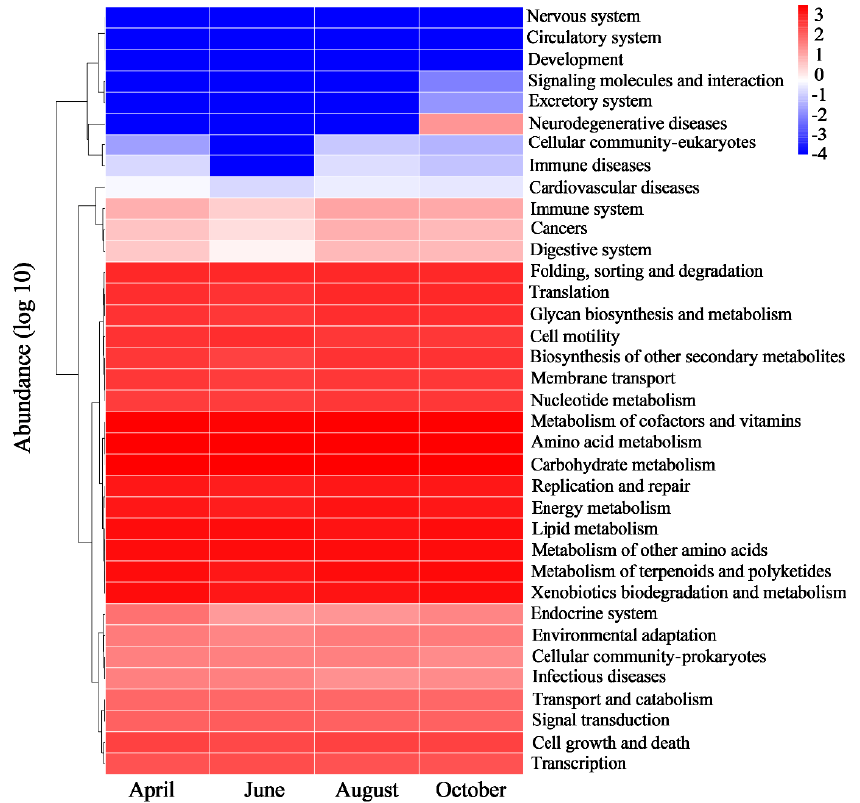
Figure 6. Metabolic pathway abundance heatmap.